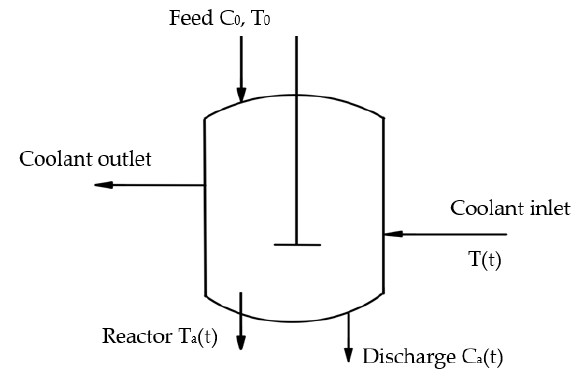
Figure 1. Schematic of CSTR.